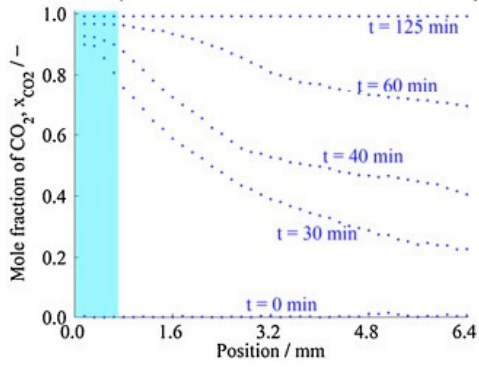
Figure 18. Representative composition profiles xCO 2 at different times (light blue color indicate the region out of the gel) [34].